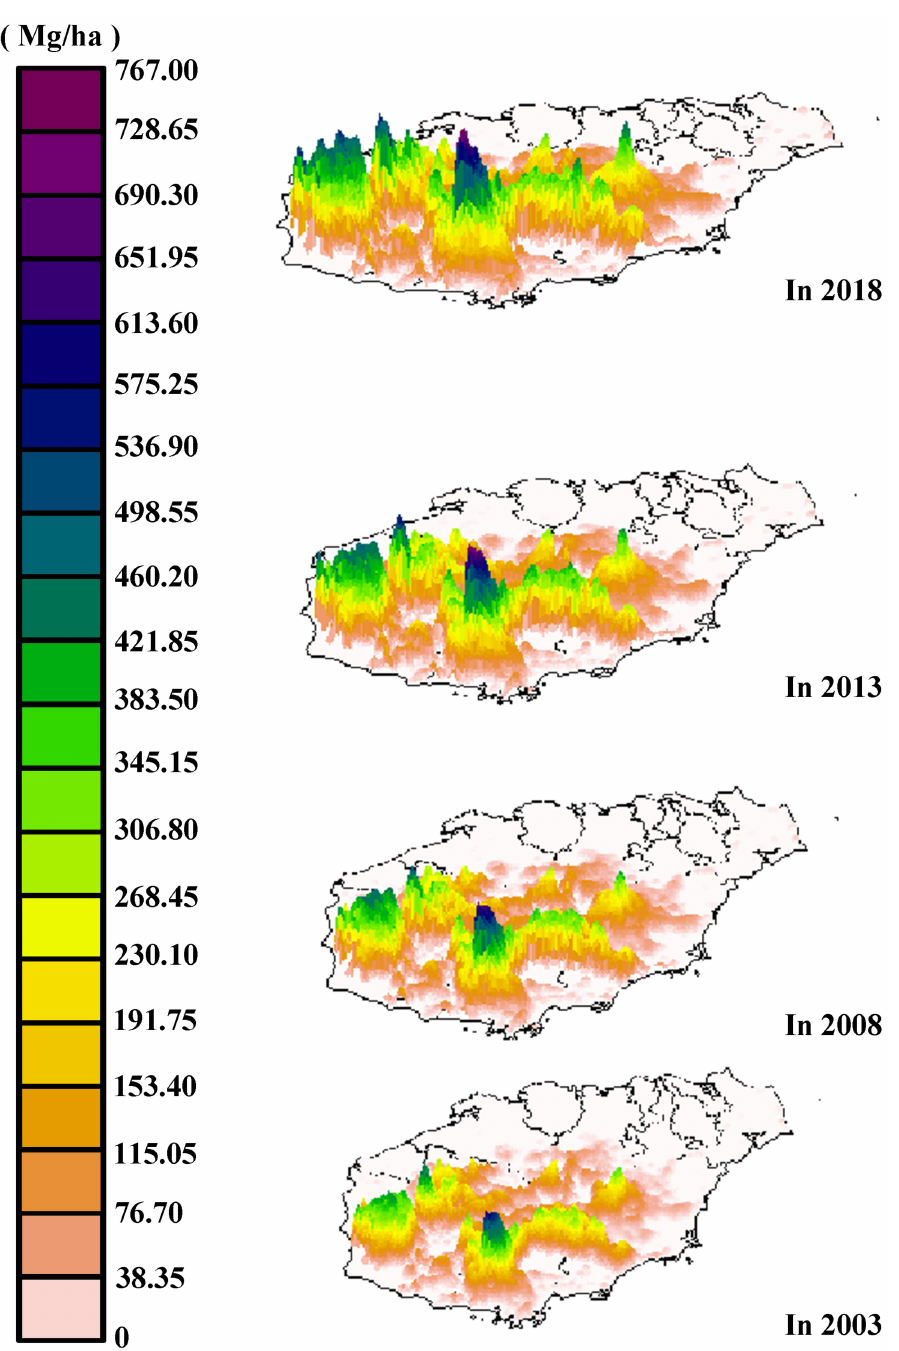
Figure 6. Spatial pattern and distribution of tropical rainforest biomass in Hainan Island from 2003 to